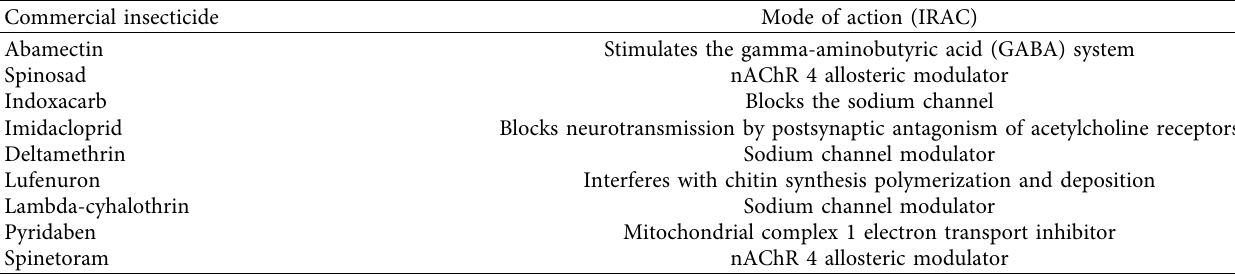
Table 2: Commercial insecticides applied against field-collected populations of S. frugiperda